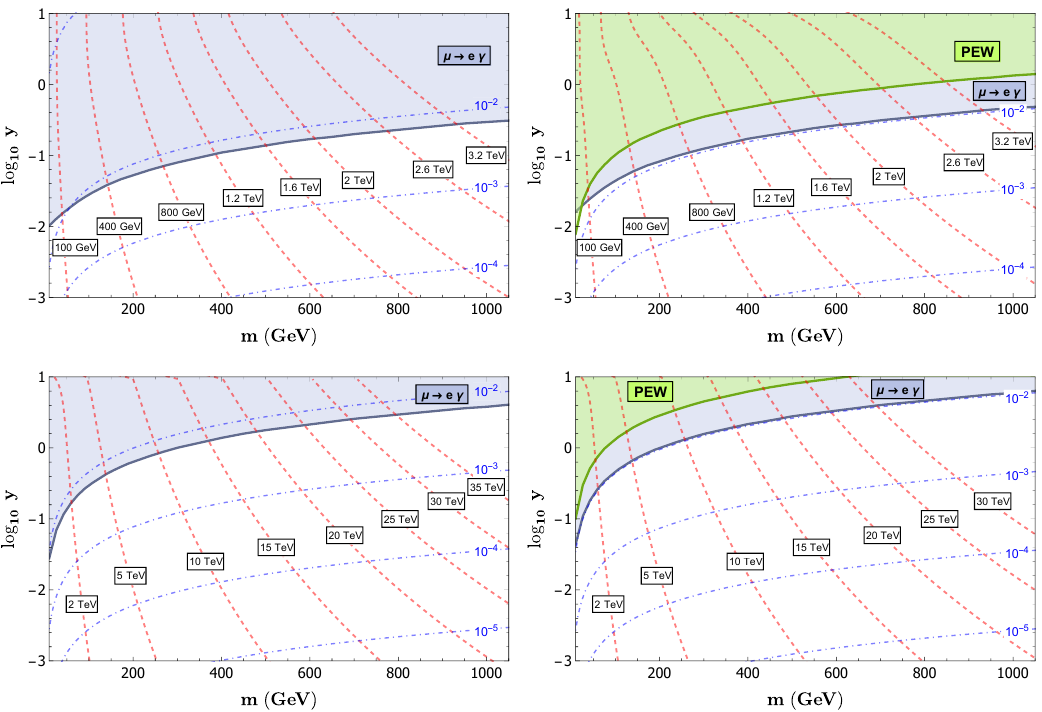
Figure 6 . Top row: constraints on the parameter space of the Linear CW 1 model from (cid:22) and precision electroweak (cid:12)ts. Left panel: normal (hierarchical) spectrum of active neutrinos. Right panel: degenerate spectrum of active neutrinos. Dashed/red lines indicate the mass of the lightest clockwork neutrino, while dot-dash/blue lines indicate the coupling of this state to the SM gauge currents. Bottom row: same, for the Linear CW 2 model. In the case of Linear CW 2 model, the masses and couplings of the heaviest clockwork state are plotted, since other clockwork states have strongly suppressed interactions with the